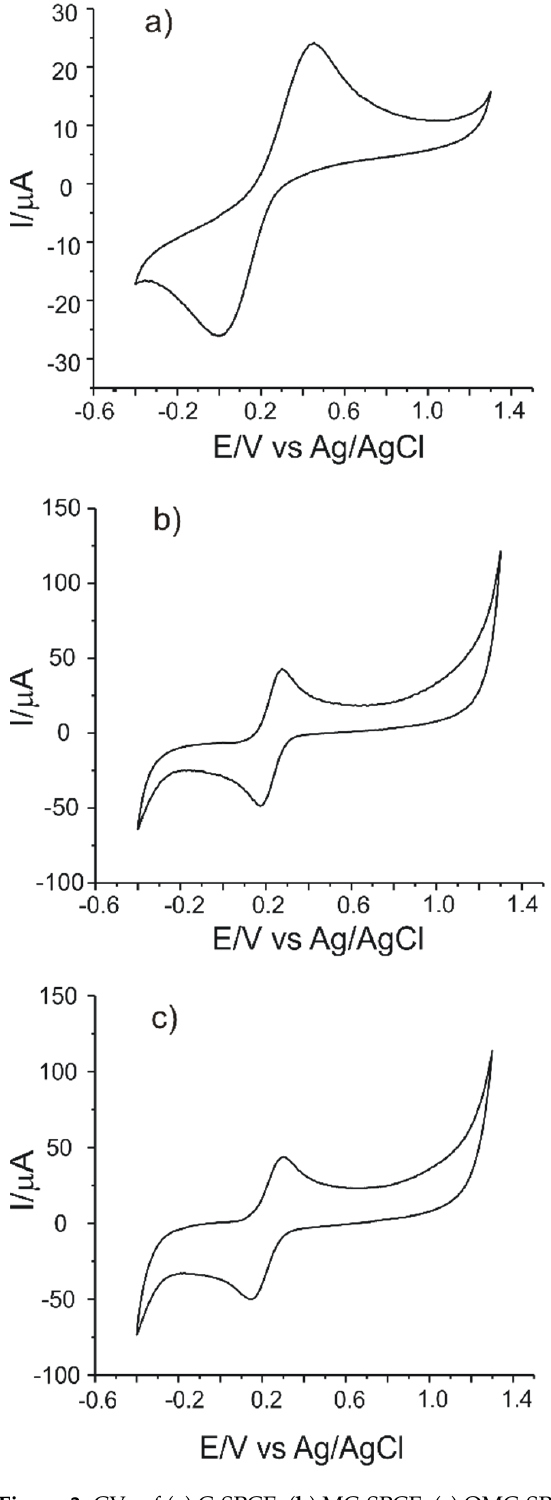
Figure 3. CVs of ( a ) C-SPCE, ( b ) MC-SPCE, ( c ) OMC-SPCE recorded in 1.0 × 10 − 3 M K 4 [Fe (CN) 6 ]-0.1 M PBS solution.